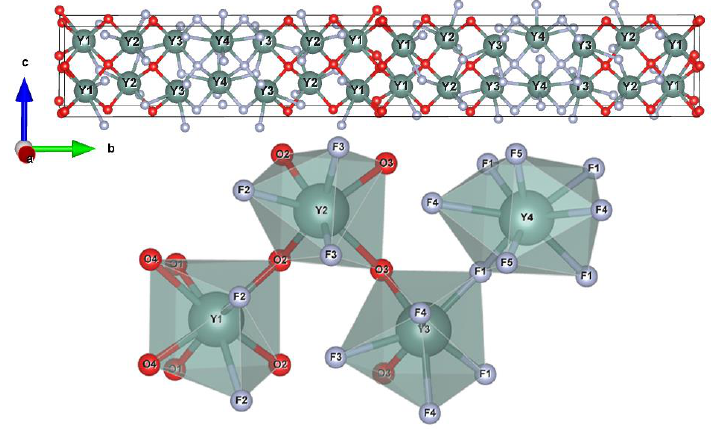
Figure 2. Crystal structure of Y 7 O 6 F 9 (above) and four kinds of coordination for Y 3+ (below).